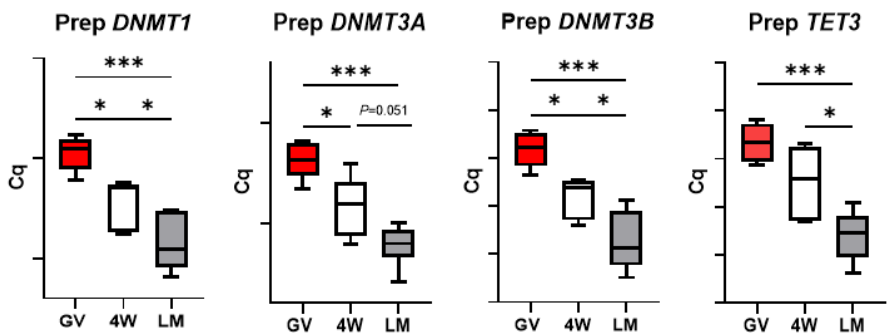
Figure 8. Expression of genes involved in DNA methylation reprogramming in pools of prepubertal GV and MII oocytes matured in 4-well plates (4W) or in liquid marbles (LM). Target gene expression was normalized against the luciferase exogenous control. Relative abundance is expressed as ∆ Cq ( Y -axis). Each box represents the mean expression of 5 replicate pools of 10 oocytes each (mean ± SE). Significant differences were assessed by ANOVA general linear model test; * p < 0.05, *** p < 0.001.